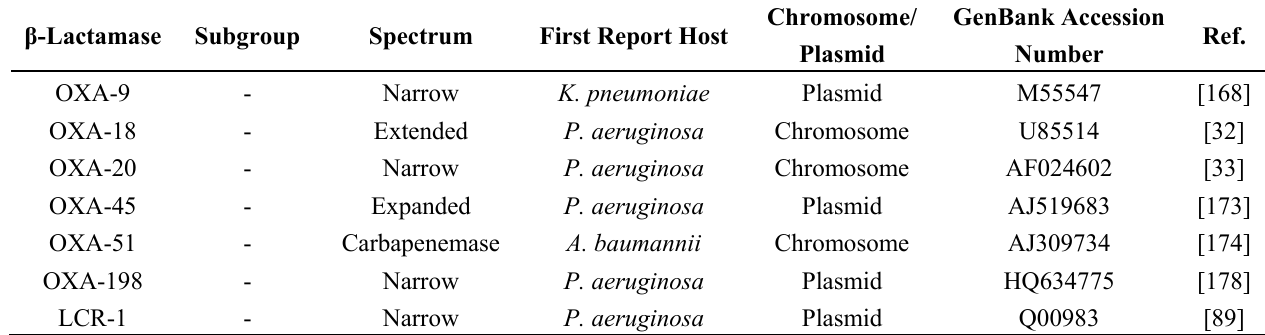
Table 15. Other OXA